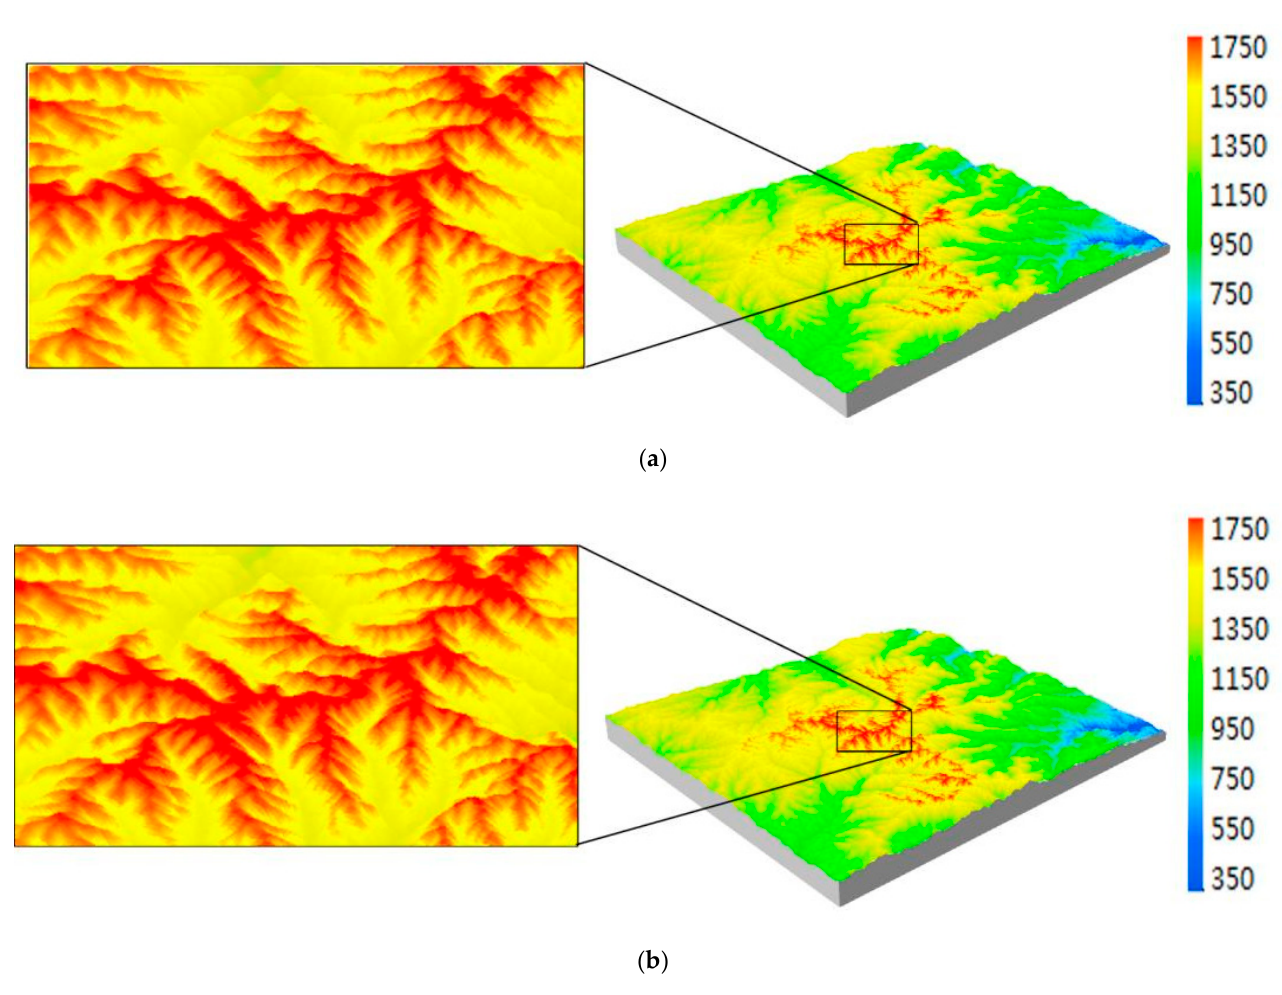
Figure 6. The surfaces modeled by the original DEM ( a ) and the proposed EDEM-SR method ( b ).